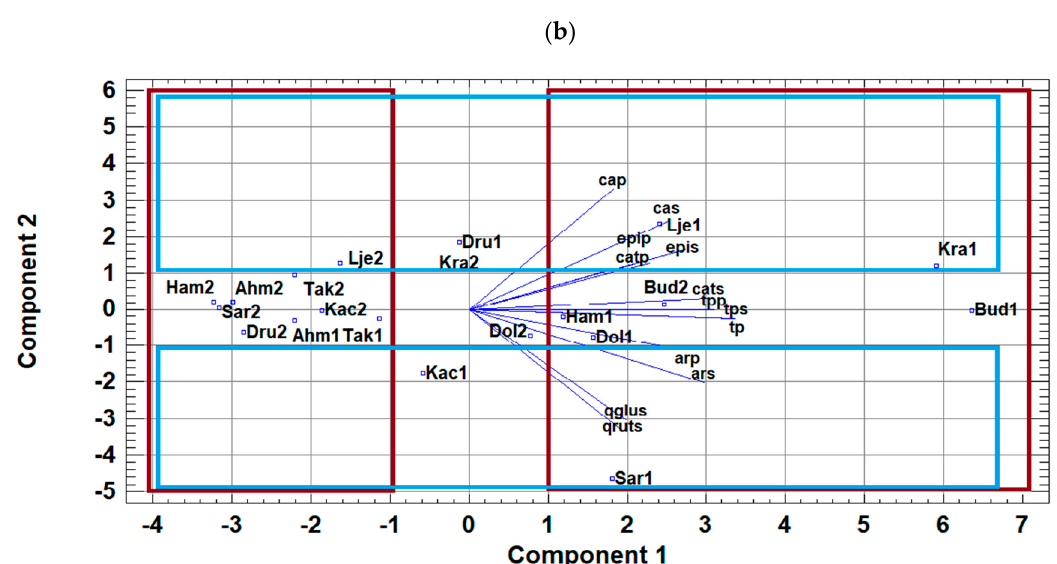
Figure 1. Principal component analysis (PCA) plots presenting graphical representation of the position of the analyzed pear cultivars from different growing seasons in relation to ( a ) analyzed sugars (gluc—glucose; fruc—fructose; suc—sucrose; ts—total sugars) and organic acids (ta—total